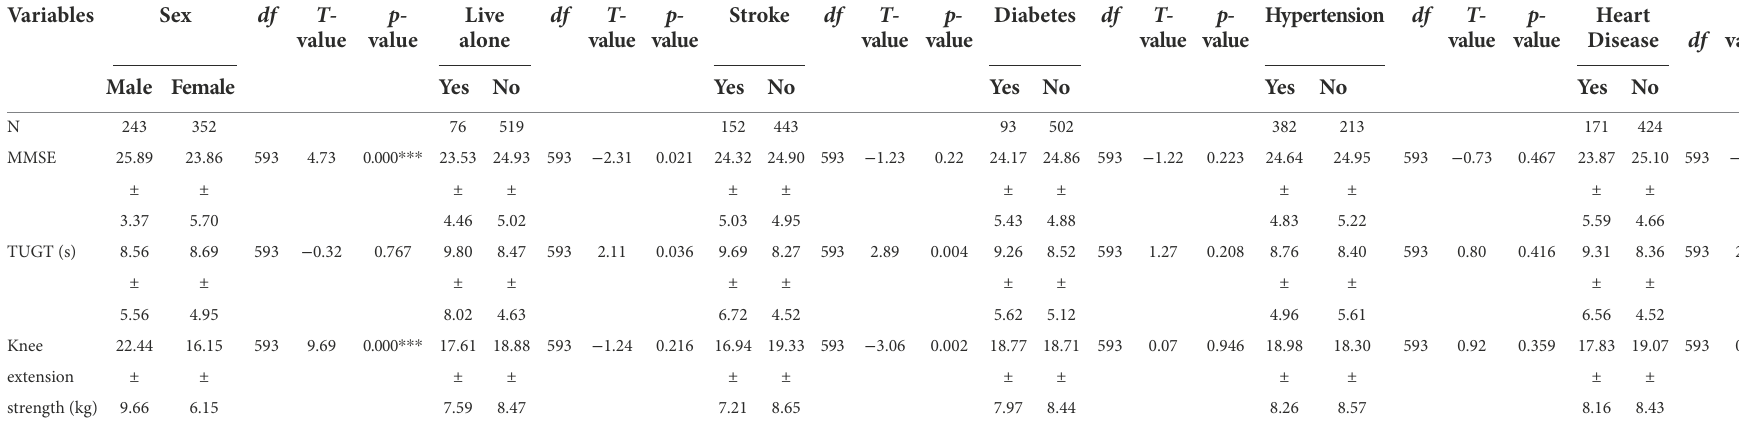
TABLE 3 Differences of MMSE, TUGT, and knee extension strength in demographic variables ( N = 595).